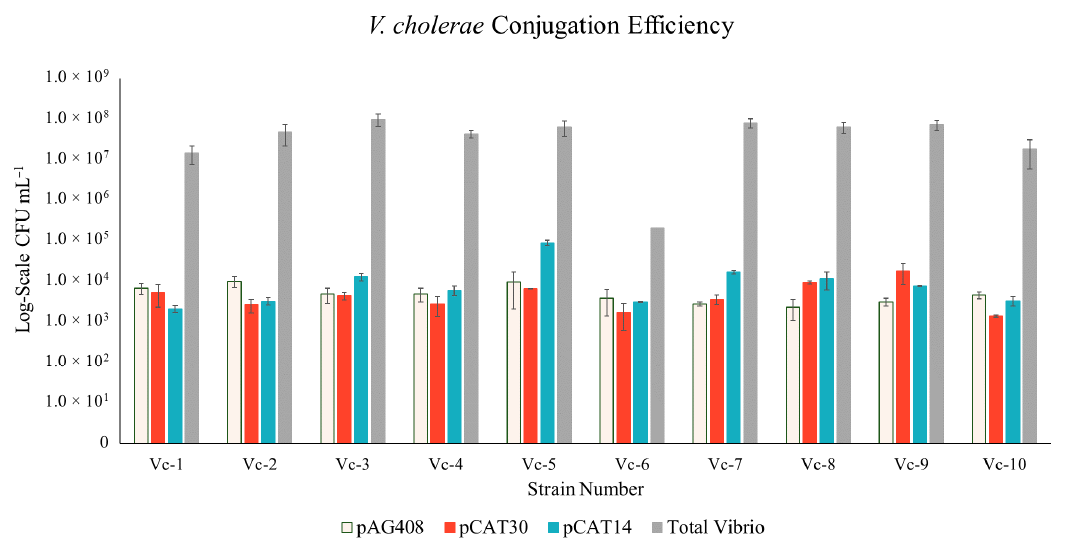
Figure 3. Transconjugant enumeration of V. cholerae strains labeled with pAG408 (white), pCAT14